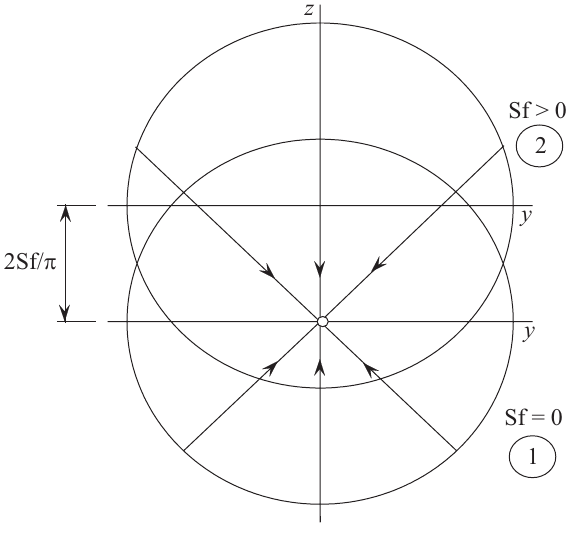
Figure 5. Particle trajectories in the gradient zone without (1) and with (2) of body